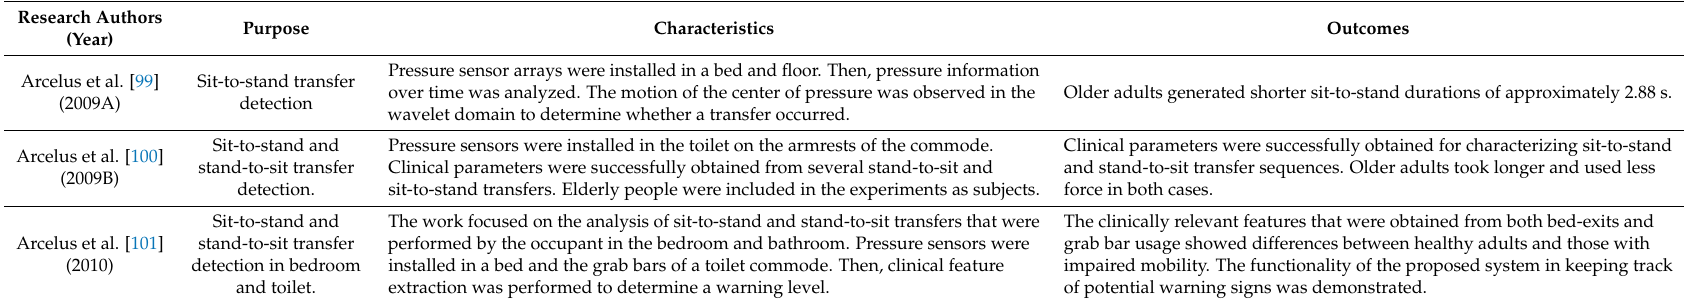
Table 4. Summary of research works that use pressure sensor technology.